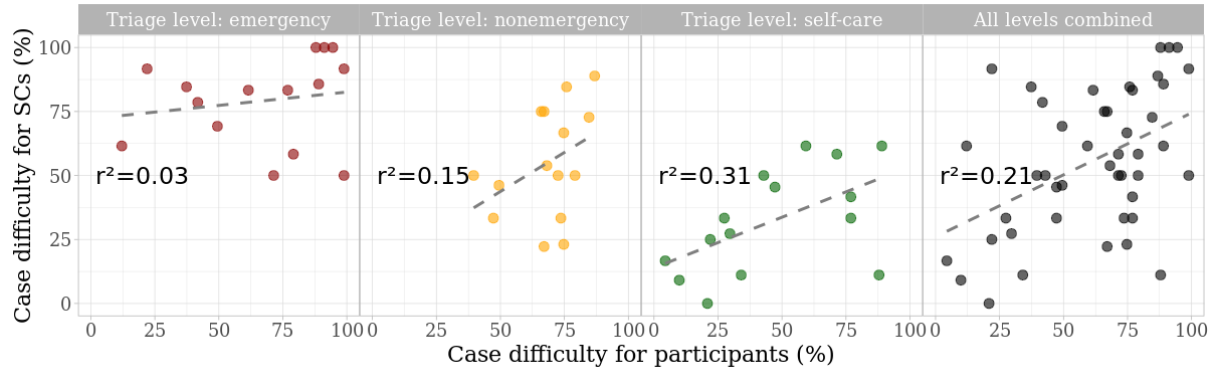
Figure 2. Distribution of case difficulty for participants and SCs. Case difficulty is defined as the proportion of the group (SC or participants) evaluating the respective case correctly. The dashed line models a linear relationship. SC: symptom checker.